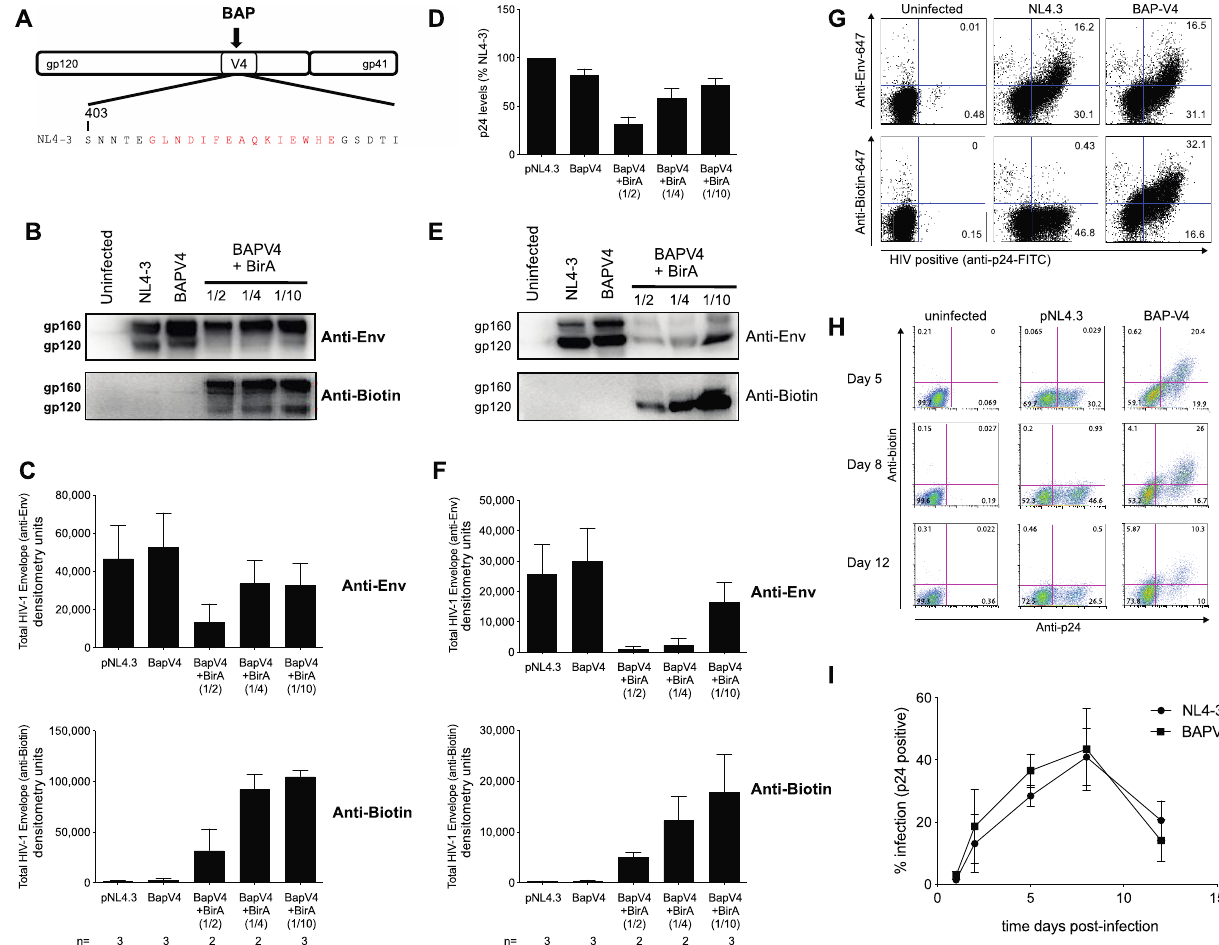
Figure 1. Development of HIV Env BAP-V4, a molecular HIV-1 clone expressing a biotinylated envelope protein. ( A ) Diagram of a biotin acceptor peptide (BAP) tag inserted into V4 region of NL4-3 Env glycoprotein. The amino acid sequence of the HIV NL4-3 gp120 Env V4 region indicating BAP insertion (red) and flanking HIV gp120 sequence (black). ( B ) Cell lysates from 293T cells transfected with HIV BAP-V4 were examined by Western blot with anti-Env (upper) and anti-biotin (bottom) antibodies. Cells were transfected with wild-type NL4-3 virus or HIV BAP-V4 and different ratios of Env/biotin protein ligase (BirA): 1:2, 1:4 and 1:10. ( C ) Densitometry of anti-Env (upper graph) and anti-biotin (lower graph) showing mean densitometry units from independent Western blots of transfected cell lysates. The number of repeat blots for each sample is shown (bottom). ( D ) Viral production from 293T cells transfected with wild-type virus or HIV BAP-V4 with and without different plasmid ratios of biotin protein ligase (+BirA 1:2, 1:4 and 1:10) was measured using p24 ELISA. The mean values of a triplicate replicate experiment are shown. Similar results were observed in three experiments conducted in triplicate. ( E ) Western blot of wild-type (pNL4-3) or HIV BAP-V4 viral particles purified through a 20% sucrose cushion. HIV BAP-V4 viral particles were produced in the presence of different plasmid ratios of biotin protein ligase (+BirA 1:2, 1:4 and 1:10). Western blots were probed with anti-biotin (upper panel) or anti-Env (bottom panel) antibodies. ( F ) Densitometry of anti-Env (upper graph) and anti-biotin (lower graph) showing mean densitometry units from repeat Western blots of virus particles. The number of repeat blots for each sample is shown (bottom). ( G ) Jurkat BirA (J-BirA) cells were spinoculated with 10 ng of cell-free WT HIV NL4-3 or HIV BAP-V4, and the levels of viral protein expression were assessed 48 h later. Flow cytometry plots show the levels of HIV Env and Gag p24 detected in uninfected (left panels), NL4-3- (middle